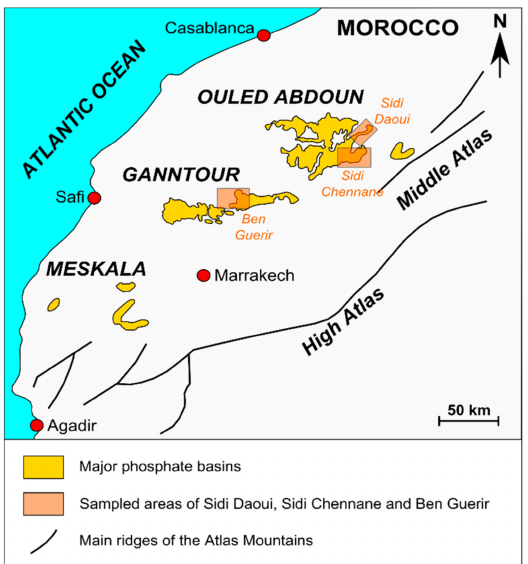
Figure 6. Location of the studied phosphorite ores of western Morocco [30].